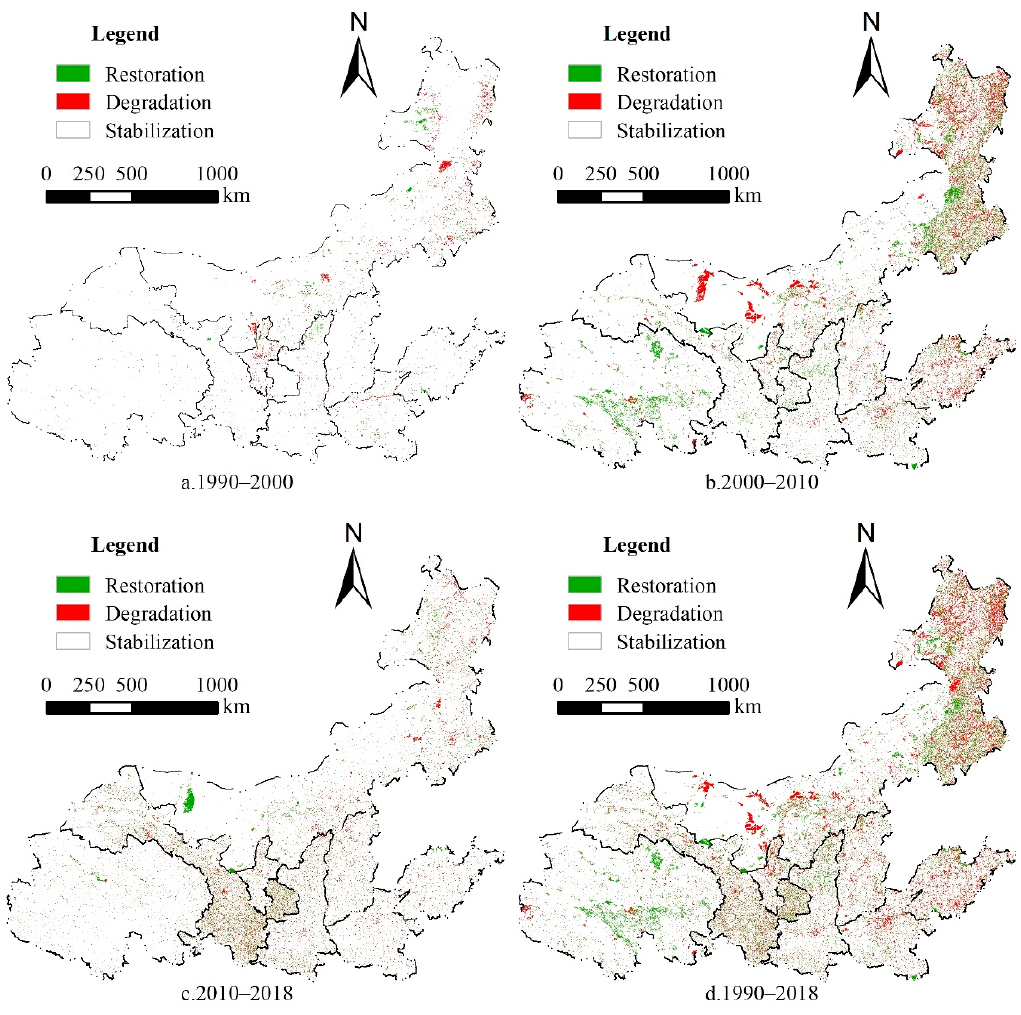
Figure 5. ESV changes in different study periods.